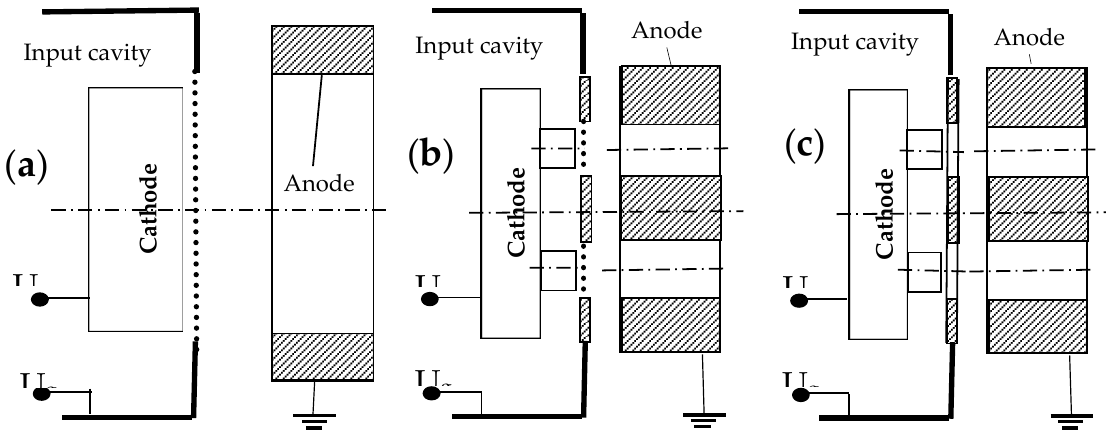
Figure 11. Types of near-cathode parts of O-type resonant microwave devices with emission modulation: ( a ) single-beam grid design, ( b ) multi-beam (MB) grid design, ( c ) multi-beam grid-free design. Classical IOTs use variant (a), multi-beam IOTs use variant